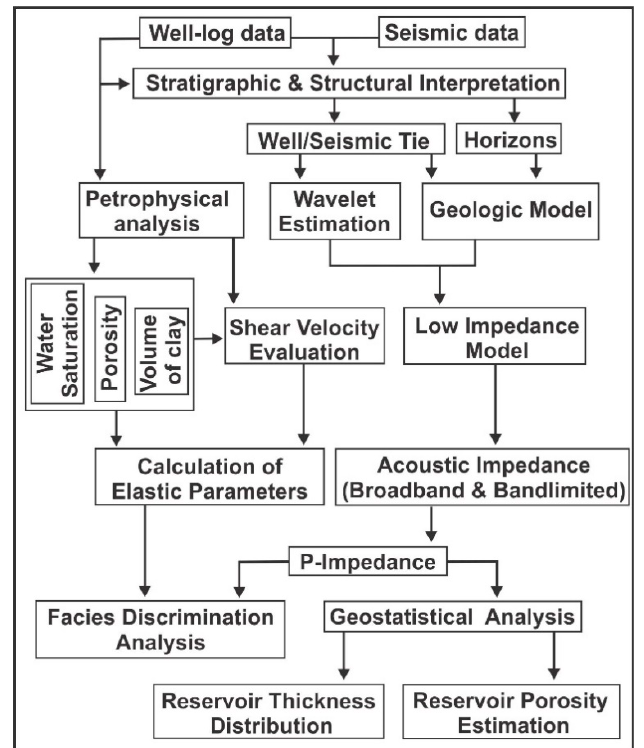
Figure 4. Workflow adopted for the current study .